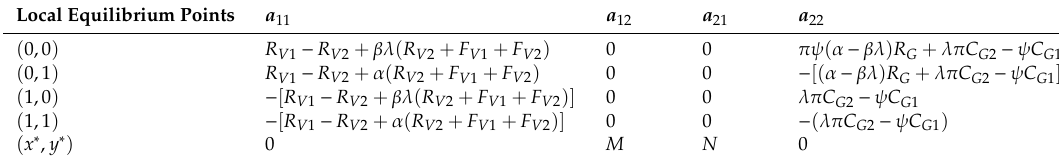
Table 3. Determinant values and trace of local equilibrium